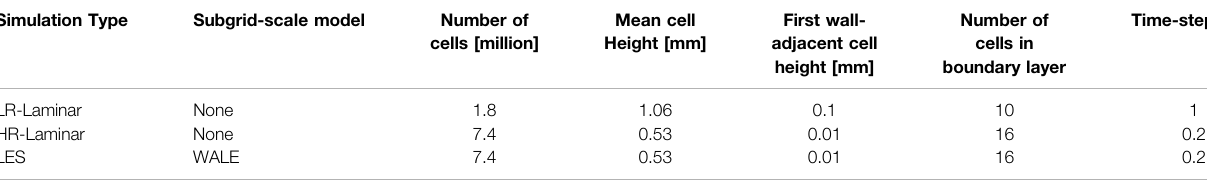
TABLE 1 | Numerical, mesh and time-step details.